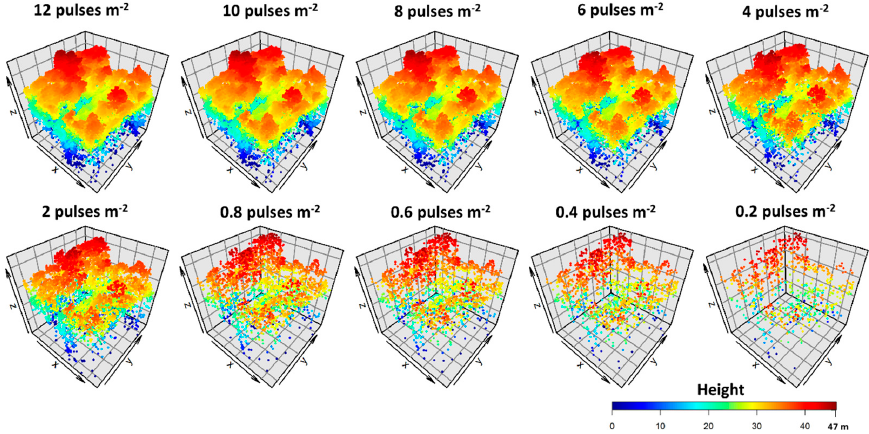
Figure 2. A 3D illustration of airborne lidar pulse density reduction at the plot level (0.25 ha) in 2014.